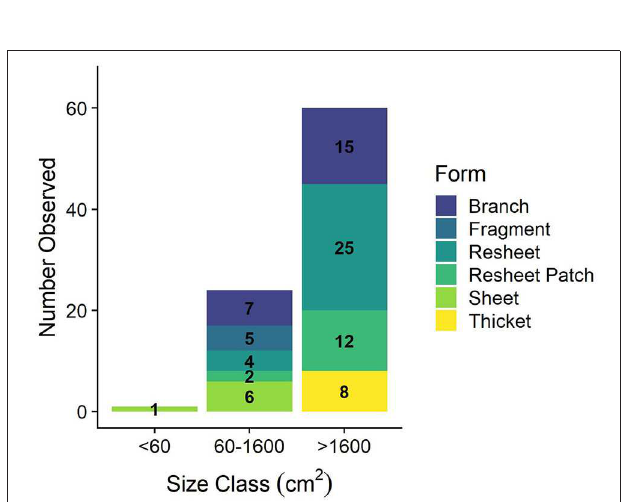
FIGURE 4 | Elkhorn colony size class distribution. Definition of size classes from Larson et al. (2014) and classification of a colony or patch determined from LAI measurement (cm 2 ).